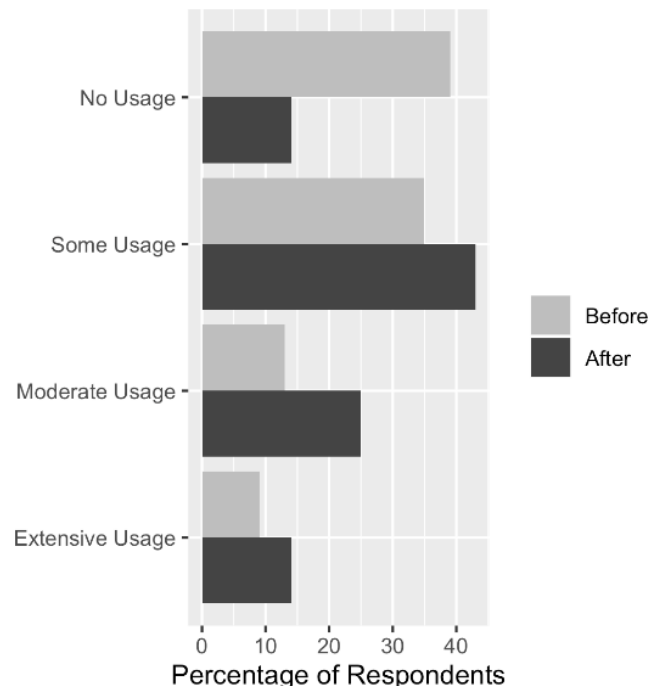
Figure 5. Participants’ self-evaluation of their satellite data usage before taking the satellite course (light gray) and after taking the satellite course (dark gray). Data are from a poll sent out to all participants who had taken the course between 2006 and 2019. Ninety-six responses were received from 293 surveys sent out, a response rate of 33%.